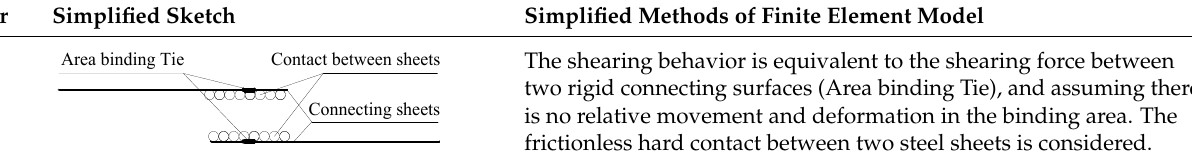
Table 5. The first simplified methods of the finite element model for the SPR joint.